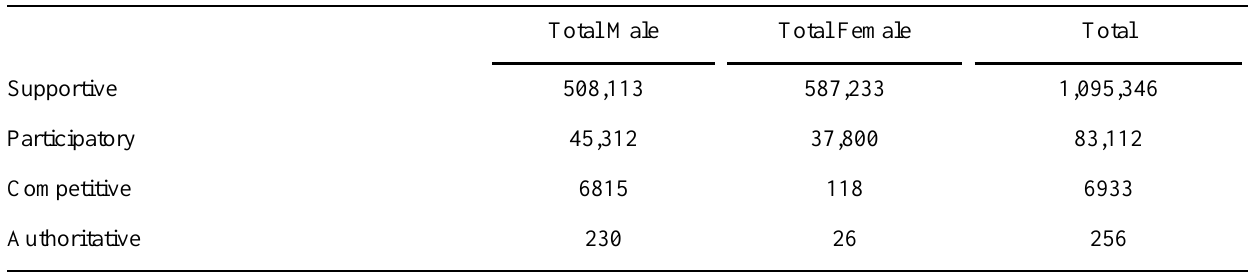
Table 2. The sample size of males and females in each category decreased by an order of magnitude as the type of bird-related recreation becomes more